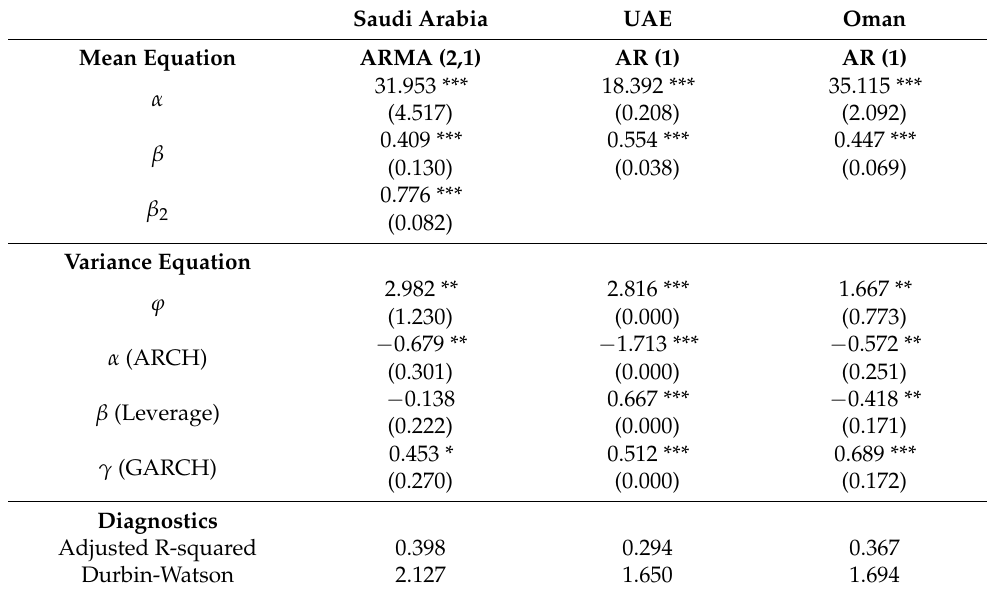
Table 3. Results of Conditional Volatility of Natural resources rents derived from EGARCH